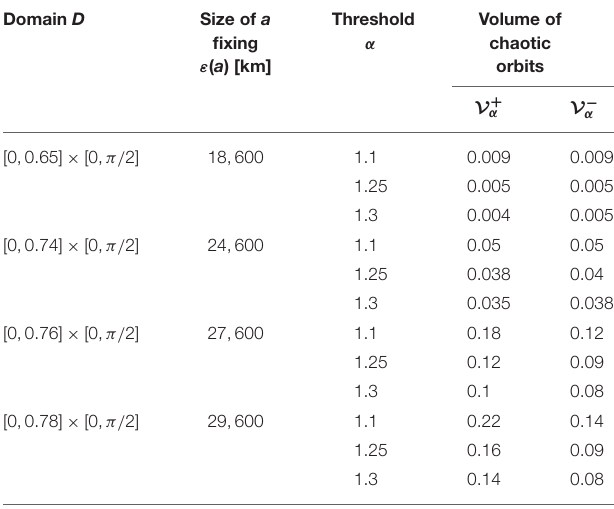
TABLE 1 | The estimation of the volume of chaotic orbits in the prograde and retrograde regions, for various perturbing parameters and on various domains. Domain